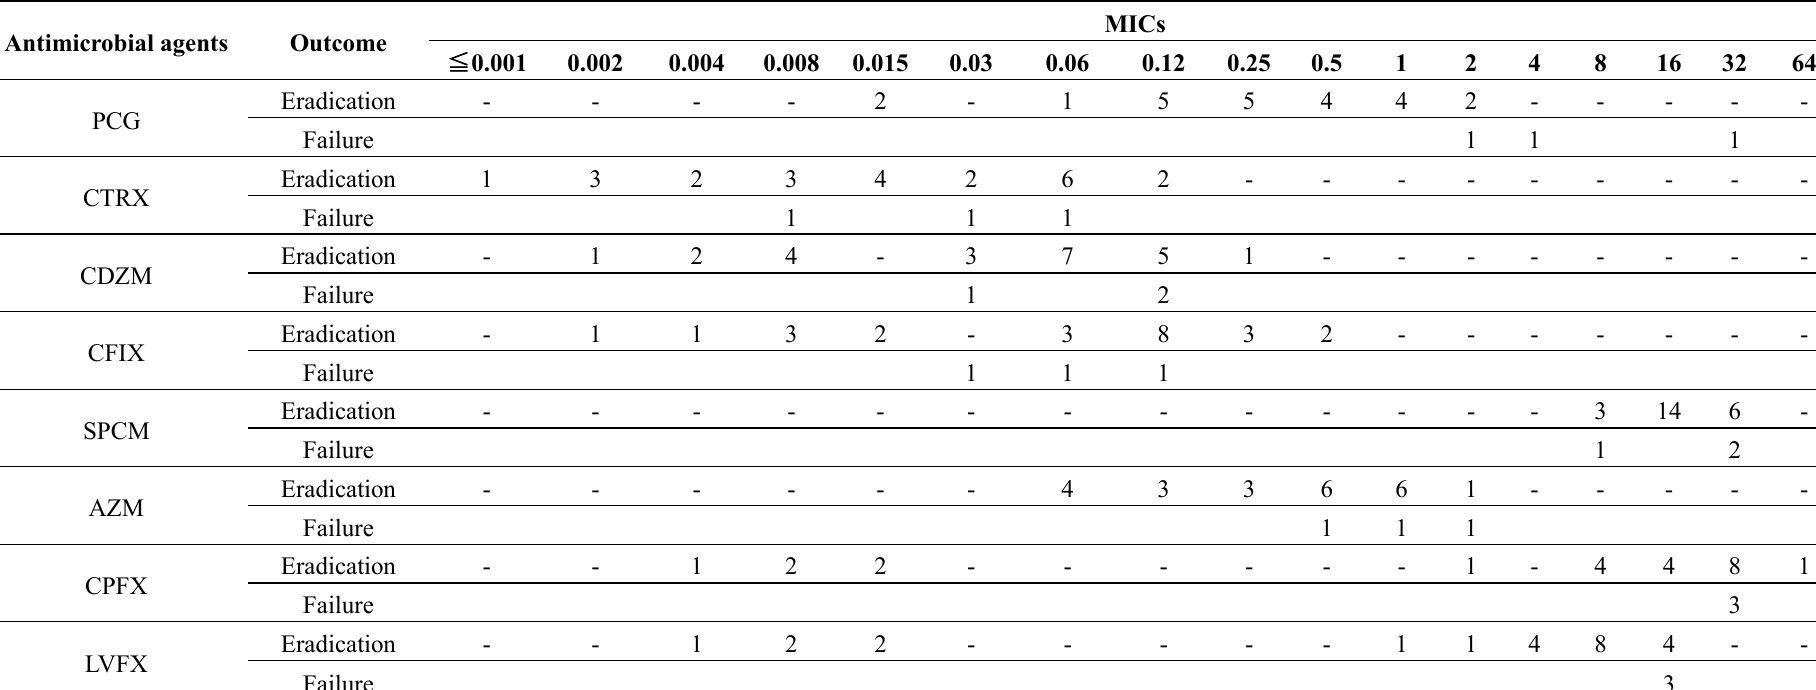
Table 2. The MIC distribution of each antimicrobial agent against 26 clinically isolated N. gonorrhoeae strains in the patients with GU for whom it was possible to judge microbiological outcomes. Eradication means no N. gonorrhoeae detected by culture after treatment with AZM ER. Failure means N. gonorrhoeae detected by culture after treatment with AZM